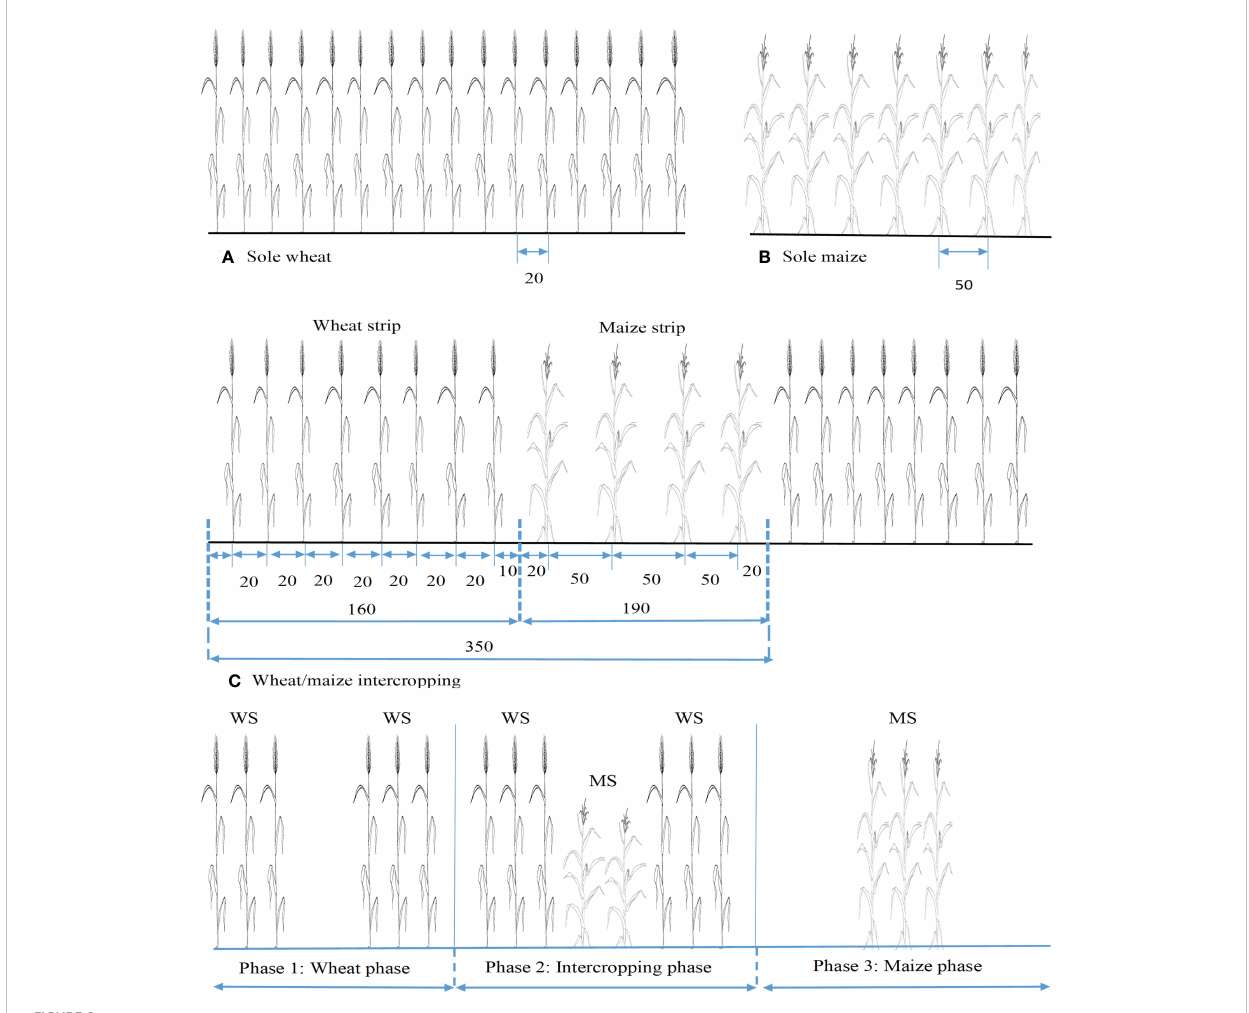
FIGURE 2 Layout of sole- (A, B) and strip- (C) intercropping of both